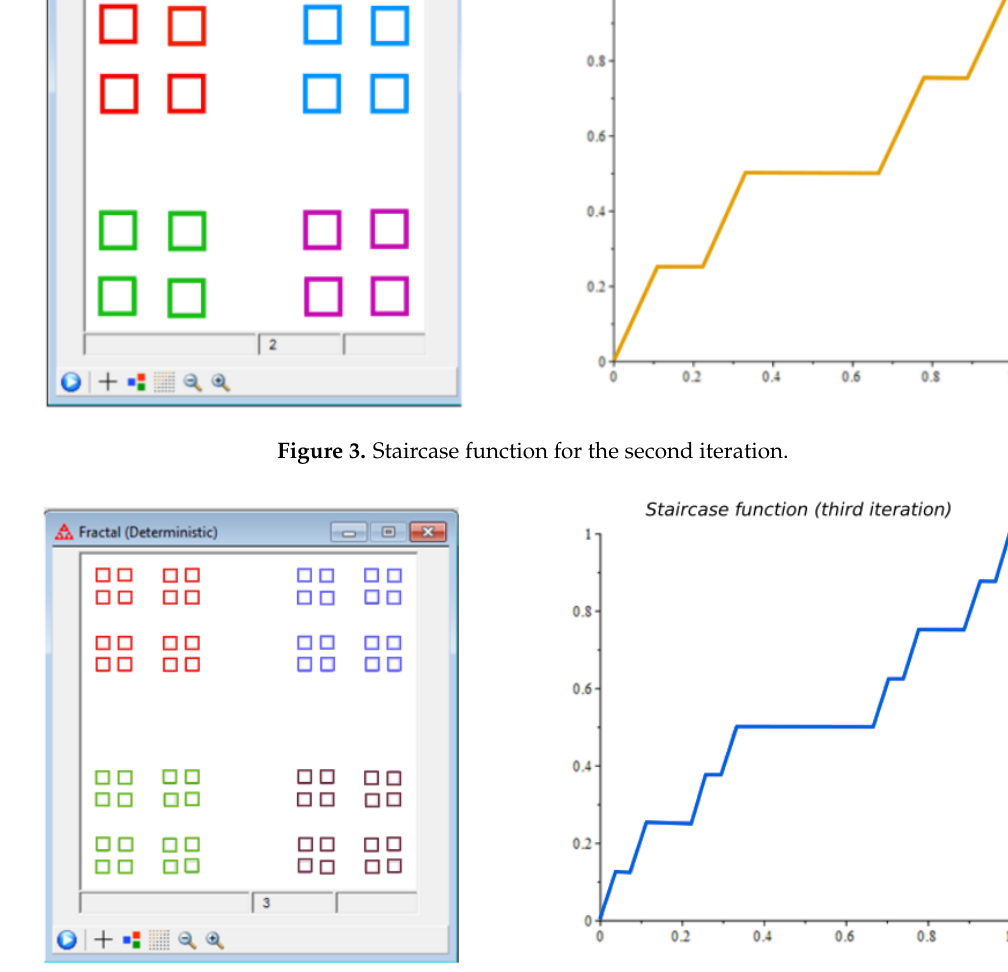
Figure 4. Staircase function for the third